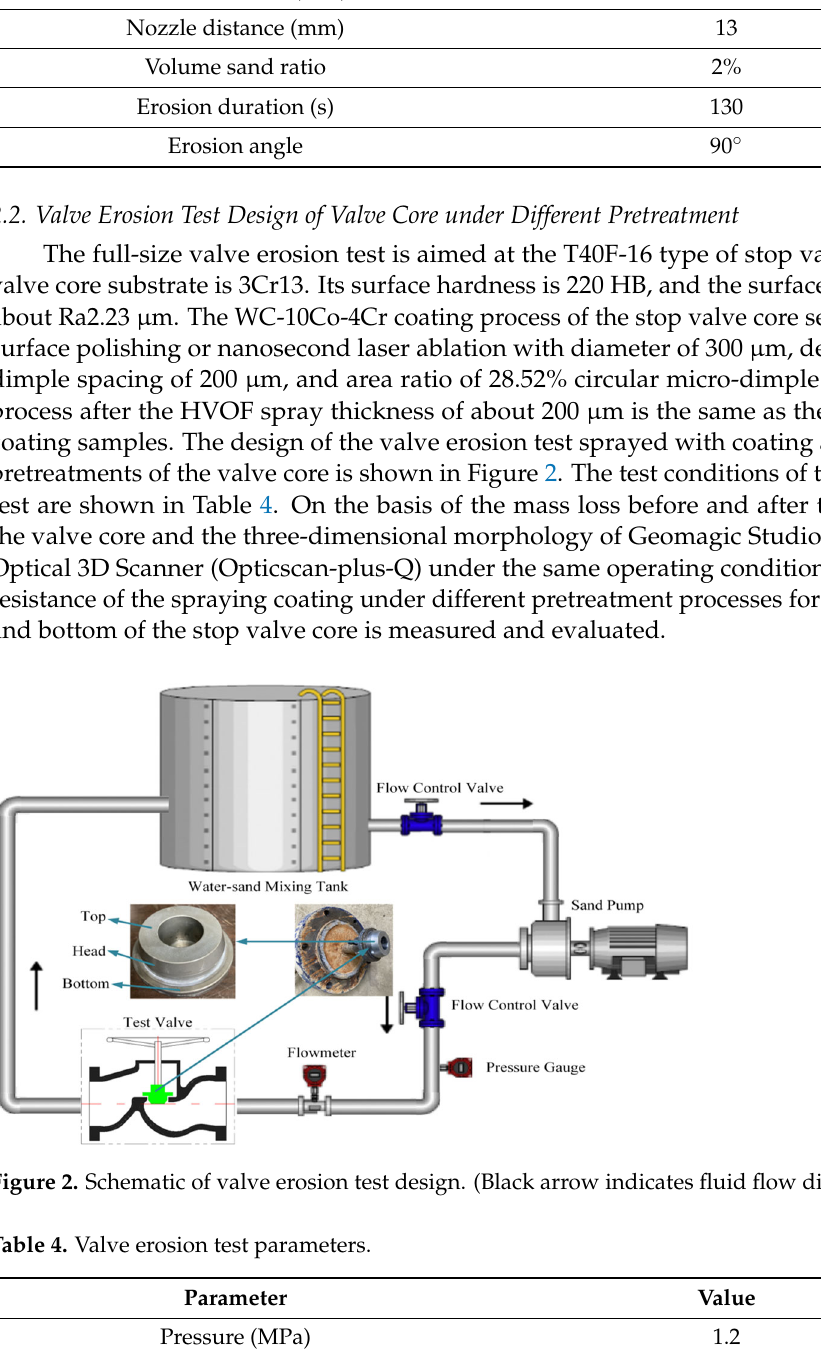
5 of 16 Figure 1. Erosion test design of liquid–solid two ‐ phase flow of WC coating unit. ( a ) Schematic of coupon erosion test. ( b ) SEM micrograph of erosion solid particles. Table 3. coupon unit erosion test working parameters. Parameter